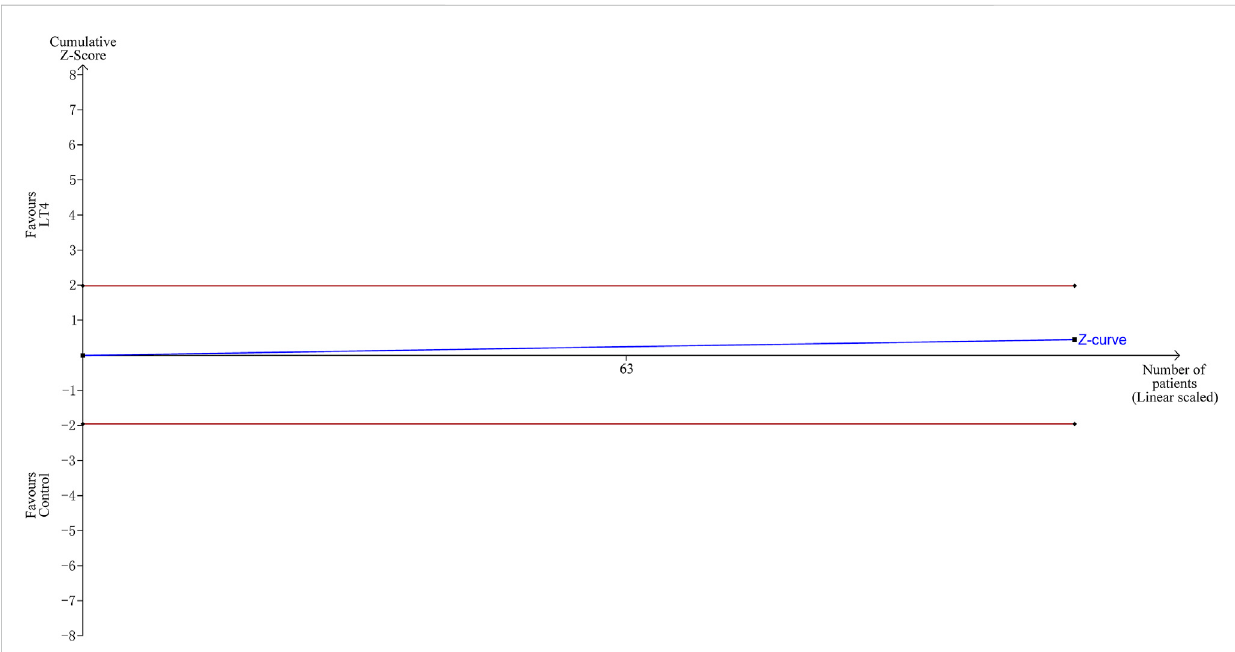
FIGURE 4 Trial sequential analysis of preeclampsia. The risk of type I error was set at 5% with a power of 80%. The relative risk reduction (RRR) was set at 20%. The variance was calculated from the data obtained from the included